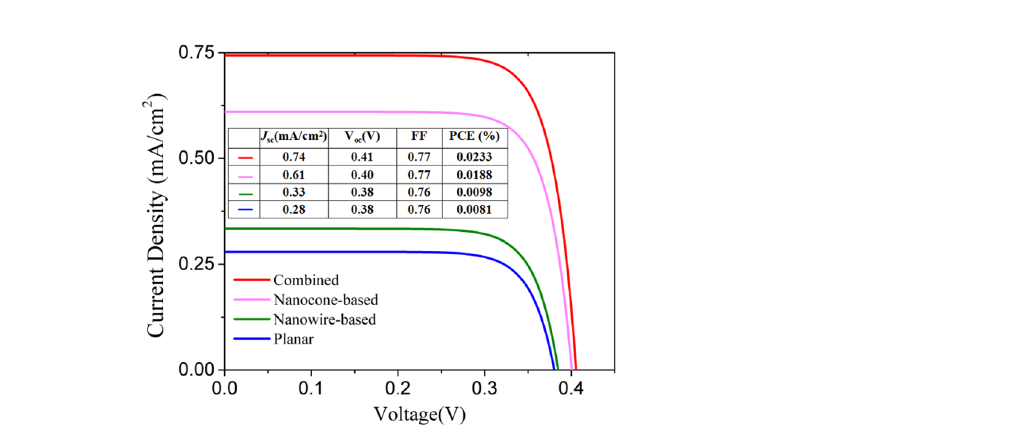
Figure 6. ( a ) IQE of a Au-TiO 2 Schottky diode as a function of Au film thickness, t Au , and the photon wavelength, λ . The whole λ - t Au area is divided by three curves into different regions where the hot electrons can transport N ( = 0, 1, 2, 3) round trips within the Au film. The N = 3 region is very small on the left side of the red curve. ( b ) The photocurrent density generated in the top Au film, J top (solid curves), and in the bottom Au film, J bot (dotted curves), for both p -polarization (red), s -polarization (black) as a function of the top Au film thickness, t top . ( c ) The net photocurrent density, J sc , for both p -polarization (red), s -polarization (black) and hybrid polarization (purple) as a function of t top . The other geometrical parameters are s = 10 nm, h = 1 μ m, r = 1 μ m, and p = 400 nm.